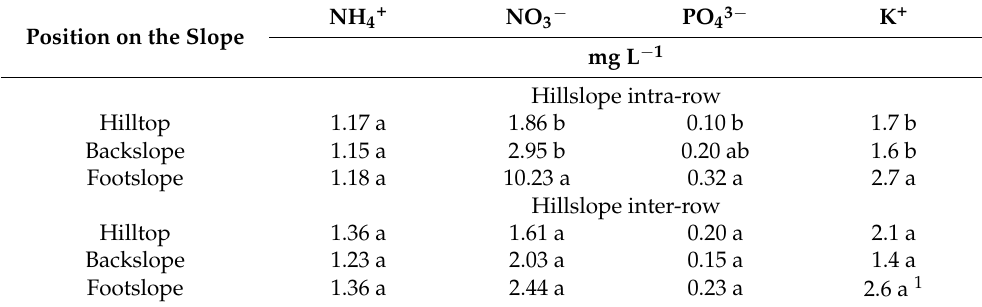
Table 2. Mean values of plant nutrient ion concentrations in leachates collected monthly for two years (2 November 2020–25 November 2022) from wick lysimeters installed at hilltop, backslope and footslope of vineyard intra- or inter-row. NH 4+ NO 3 − PO 43 − K + Position on the Slope mg L − 1 Hillslope intra-row Hilltop 1.17 a 1.86 b 0.10 b 1.7 b Backslope 1.15 a 2.95 b 0.20 ab 1.6 b Footslope 1.18 a 10.23 a 0.32 a 2.7 a Hillslope inter-row Hilltop 1.36 a